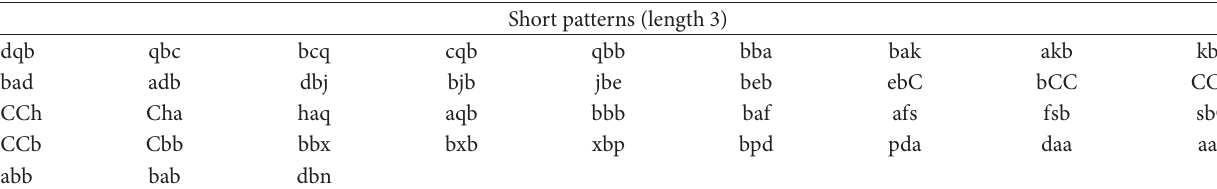
Table 5: String pattern.